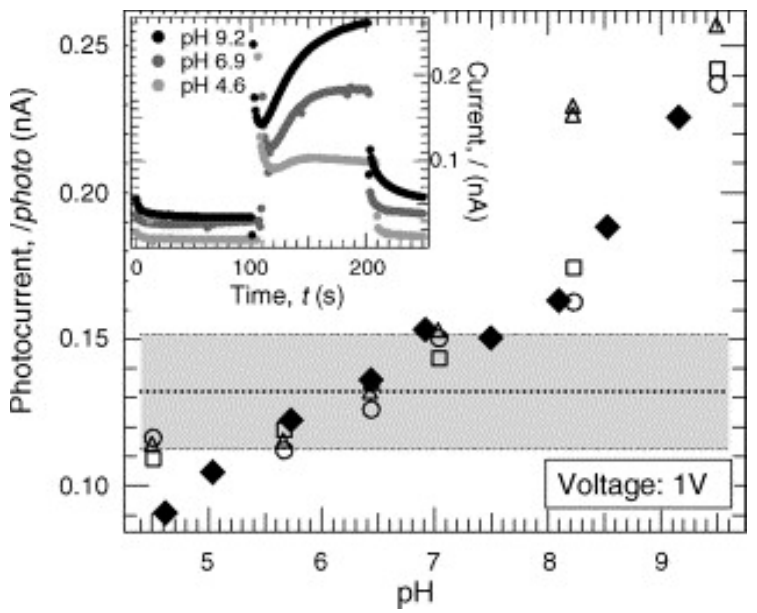
Figure 7. Variation of the photocurrent, I , for different pH values. In the inset, the light responses of ph the devices exposed to phosphate buffer (100 mM) with pH values of 4.6, 6.9 and 9.2 are shown. In the main graph the photocurrents are plotted against the pH of the buffer solution for one device (filled symbols). Three different series of the same buffer solutions are measured using a second device (open symbols) to show reproducibility. The dotted line represents the average of the DI water control measurements made in between pH measurements, with its standard deviation represented by the grey band. Reprinted from [63] © 2007 with permission from